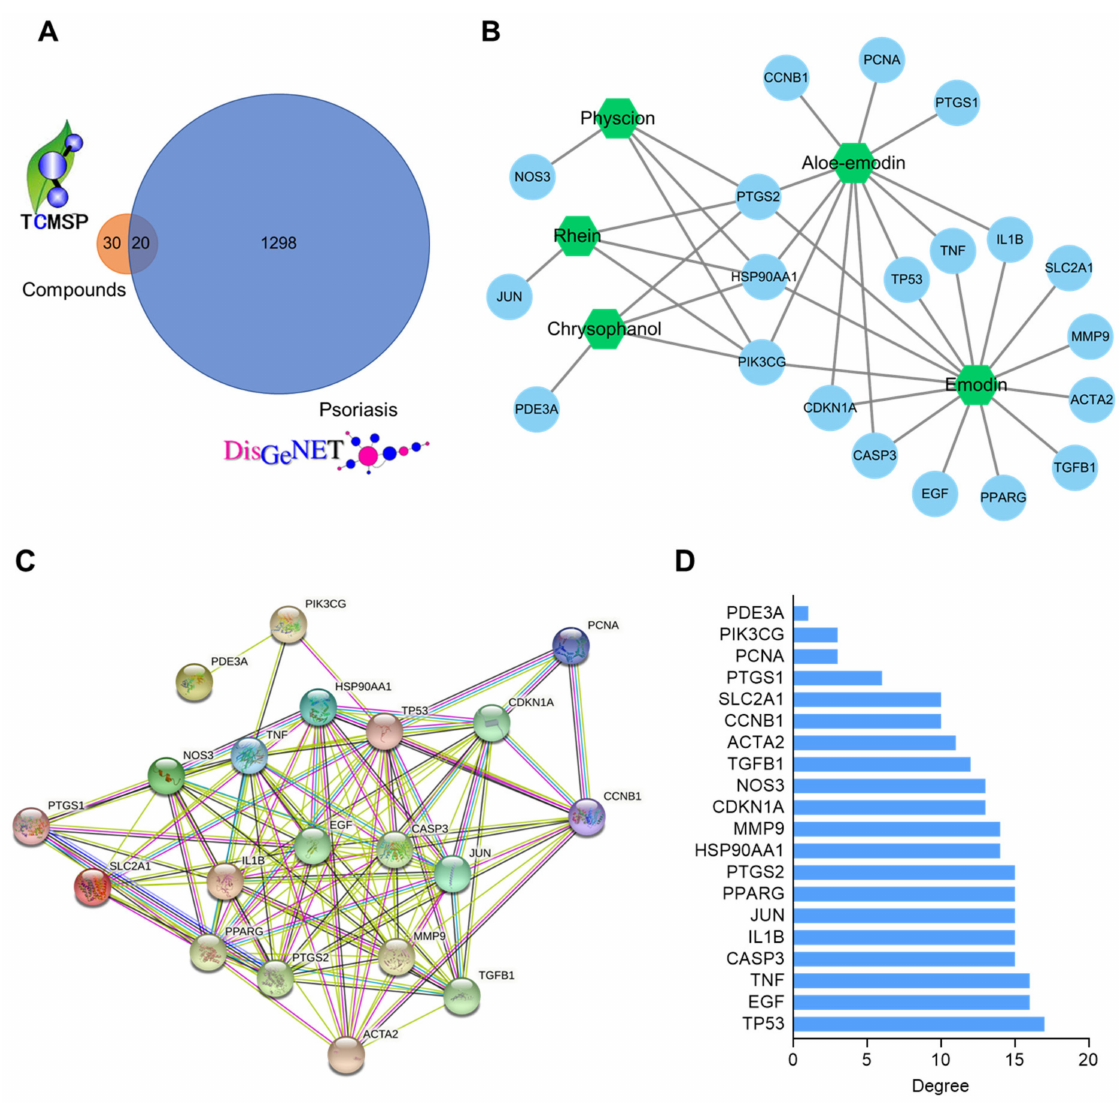
Figure 4. Compound–target and PPI network construction. ( A ) Venn diagram of the targets of RPE components and psoriasis. ( B ) Network of RPE compounds and psoriasis-related targets. Hexagons and circles represent compounds and targets, respectively. The edges are the compound– target interactions. ( C ) The PPI network of psoriasis-related targets. ( D ) Node degree of targets in PPI